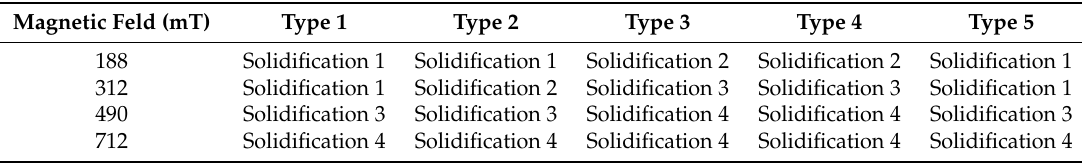
Table 3. Phenomena of Types 1–5 vulcanized MCF rubbers after electrolytic polymerization at four different magnetic field strengths.